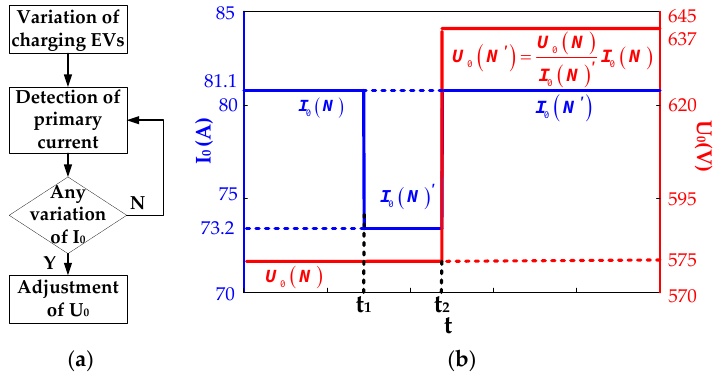
Figure 5. ( a ) Flowchart of source voltage adjustment. ( b ) I 0 and U 0 according to time (t 1 represent the time when the number of charging EVs changes and t 2 represents the time when output voltage of the source is adjusted.)